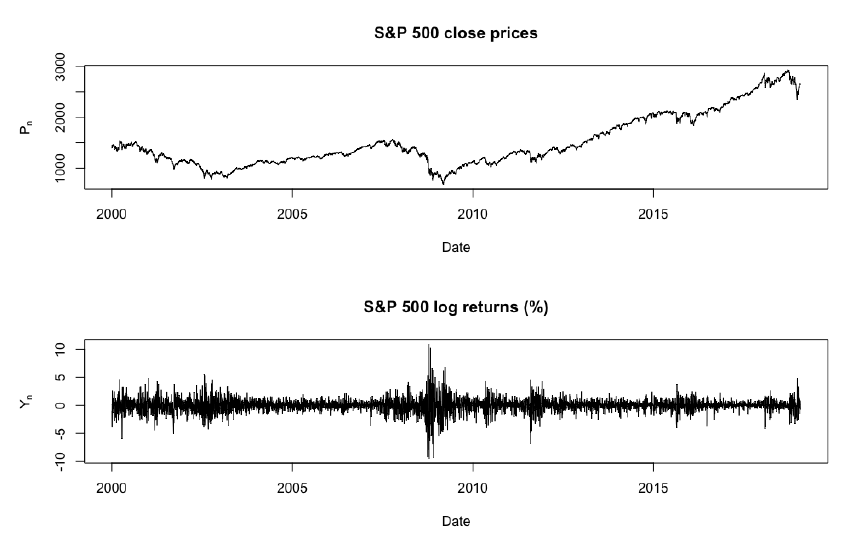
Figure 9. Daily close prices (top) and log returns (bottom) of the S and P 500 from 1 January 2000 to 28 January 2019.